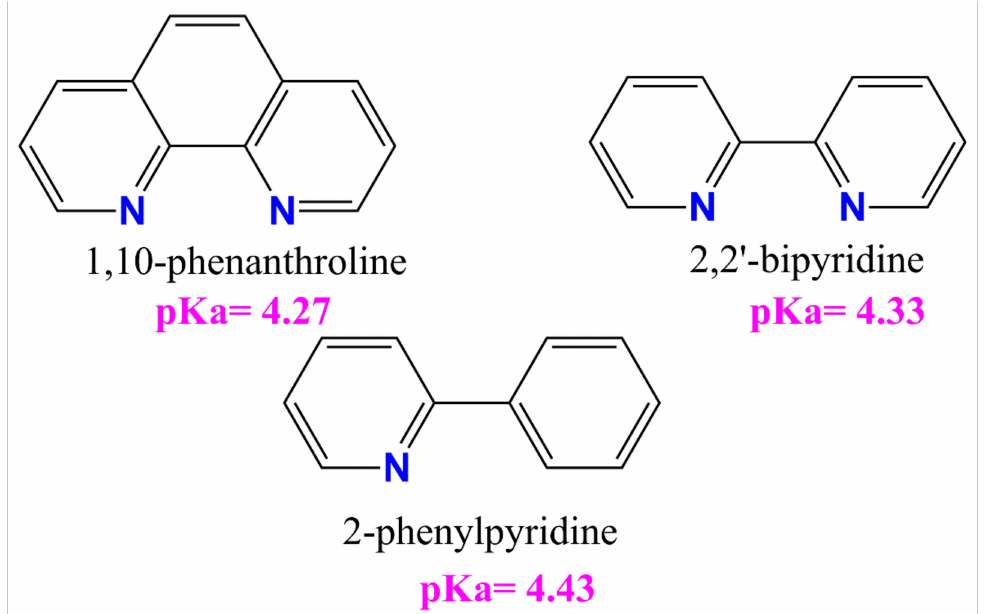
Figure 4. The auxiliary heterocyclic ligand used in the synthesis of dipicolinate oxo- and dioxo- vanadium(IV) com- plexes